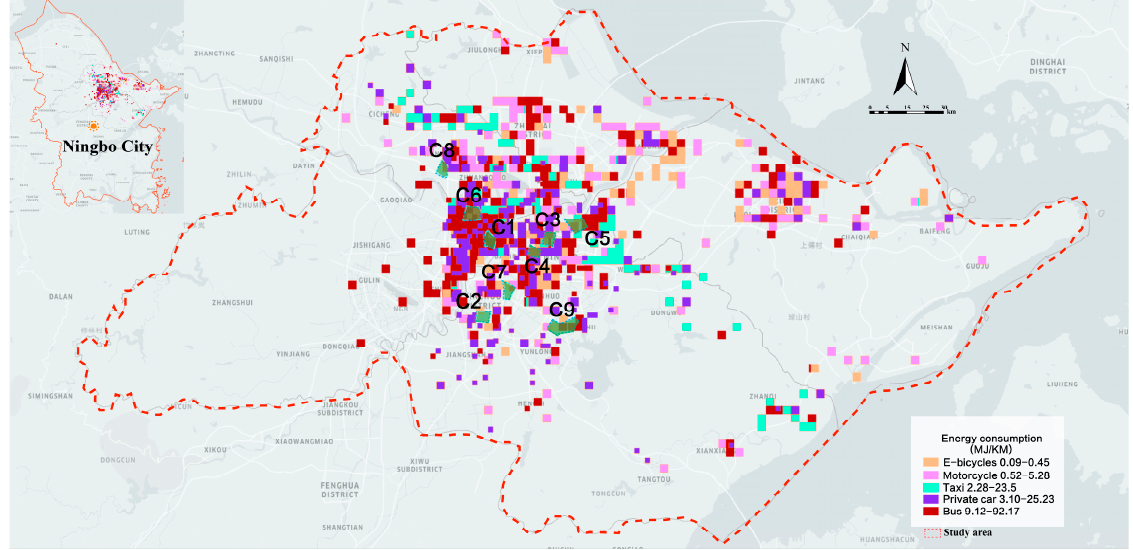
Figure 3. Spatial distribution of energy consumption of five travel modes.